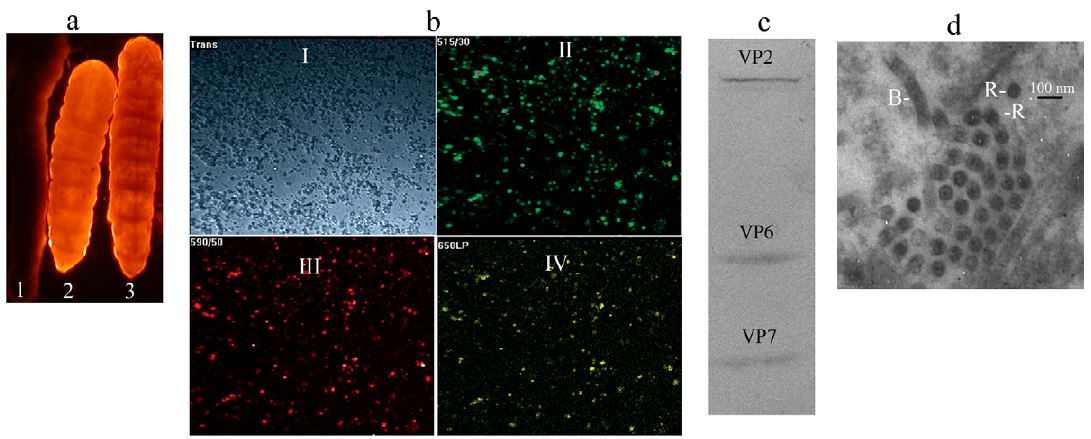
Figure 2. Multiple genes expression and rotavirus-VLPs production in silkworm. (a) The larvae of six days post injection were observed using the fluorescence detection device. 1: the mock injected larvae; 2&3: the larvae injected with invasive and DAP auxotrophic E. coli carrying BmBacmid with six genes including egfp , dsRed , eyfp , vp2 , vp6 and vp7 at a dose of 8.0 6 10 8 cells per larva. (b) The hemolymph from a red larva was observed using laser confocal microscope. The images of hemocytes were taken at the bright (trans) channel (I), GFP (515 nm) detection channel (II), DsRed (590 nm) channel (III) and YFP (530 nm) channel (IV). (c) Western blot analysis of the hemolymph from the red larvae using anti-VP2, anti-VP6 and anti-VP7 rabbit antiserums. (d) The EM image of hemocytes collected from red larvae. R: the round Rotavirus-VLPs; B: the rod shape baculovirus particle, bar=100 nm.